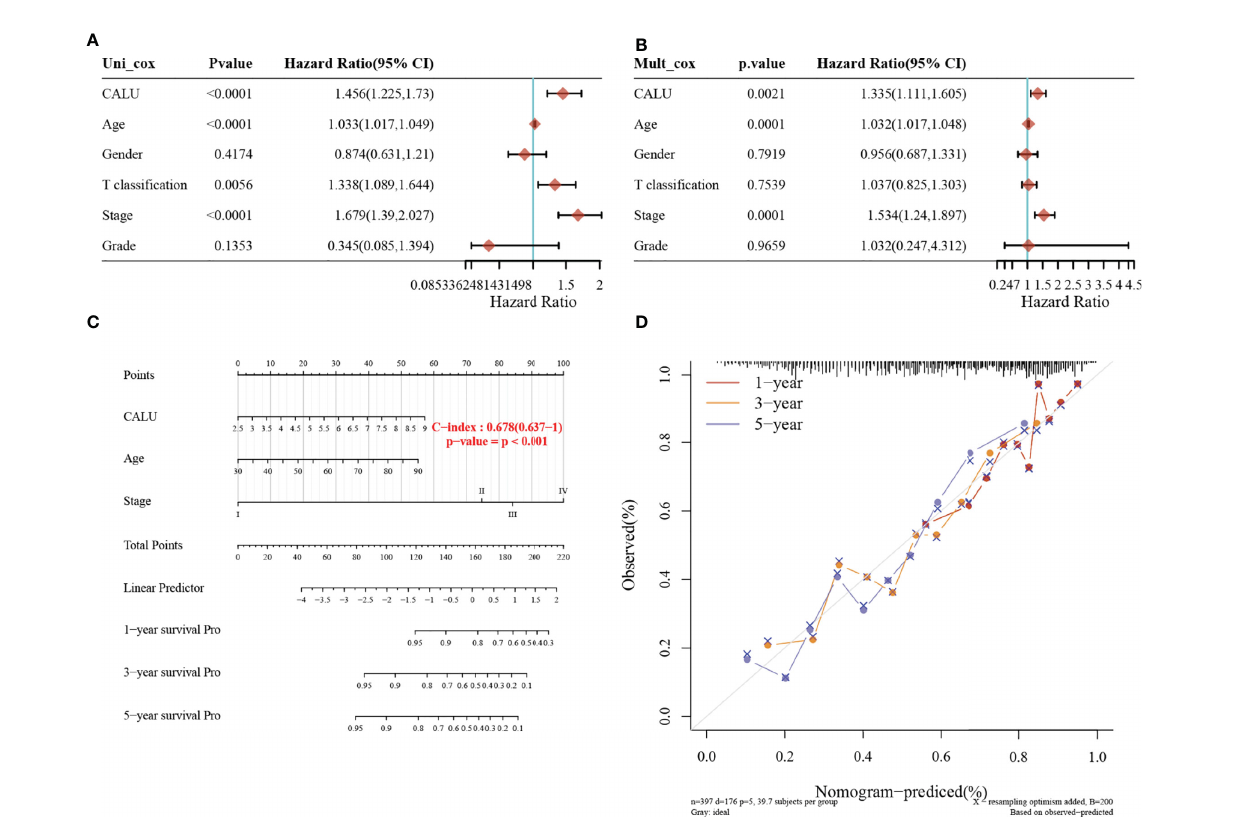
FIGURE 3 | Identi fi cation of CALU as an independent risk factor of BLCA and construction of a prognostic nomogram including CALU level. (A, B) The univariate (p<0.001) and multivariate (p=0.002) Cox regression analysis con fi rmed CALU as an independent risk factor for BLCA. (C) A nomogram composed of CALU level, age and stage well indicated the OS of BLCA patients based on the nomogram scores, with a c-index of 0.678. (D) The calibration curve con fi rmed a pleasant accuracy of the nomogram in predicting 1,3 and 5 years ’